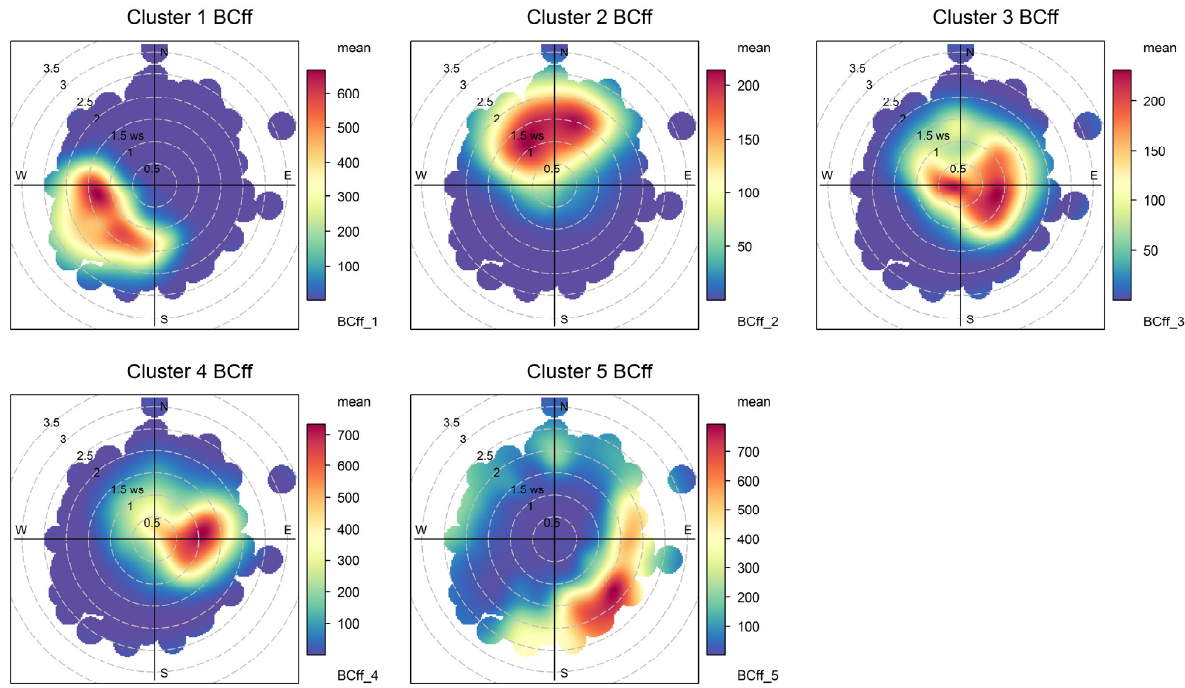
Figure 6. Bivariate plots for the five fuzzy clusters’ contributions to BC ff .